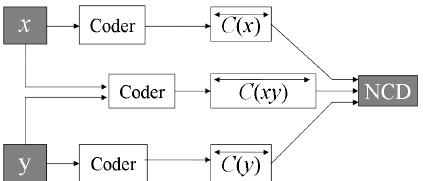
Figure 1: Computation of a distance between two general objects x and y by means of a standard compressor C . The sizes of the objects compressed separately and jointly are compared, yielding a distance ranging from 0 to